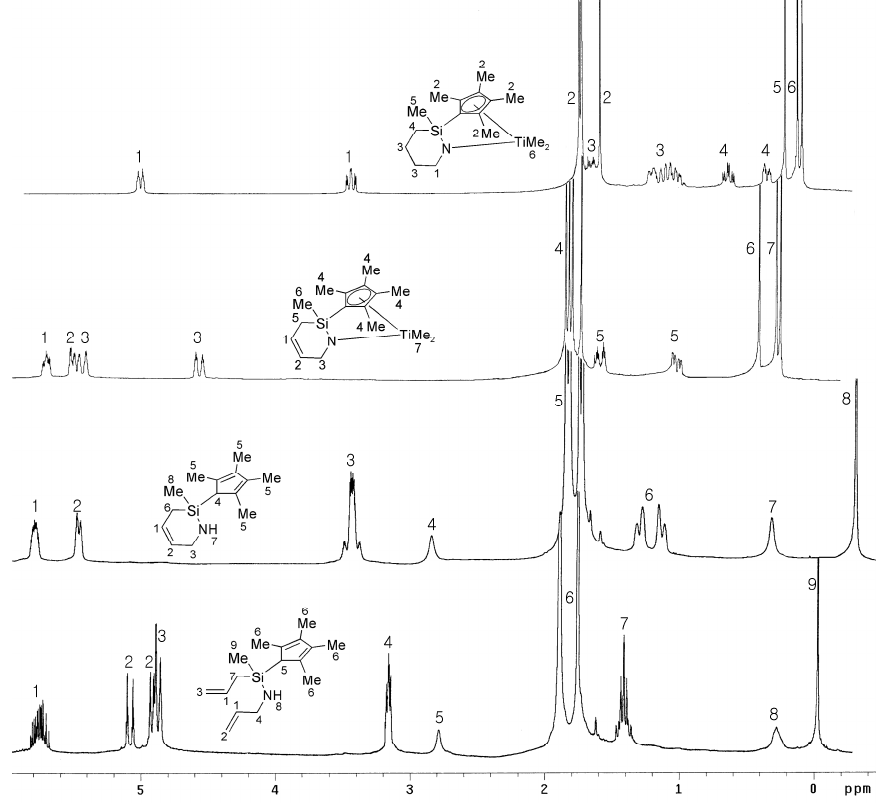
Figure 1. 1 H-NMR spectra of ring closure metathesis (RCM) precursor ( 3 ), RCM product ( 6 ), and titanium complexes ( 13 and 14 ).